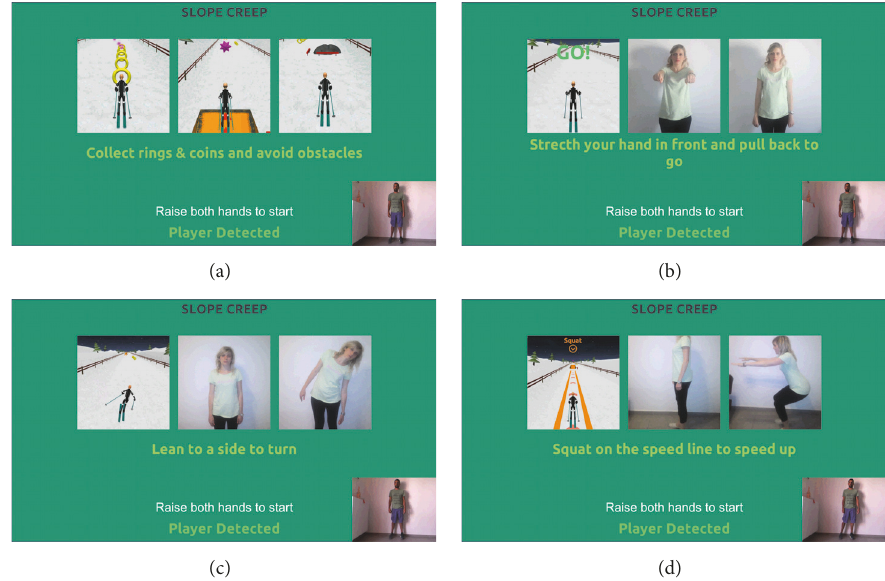
Figure10:SuccessfulrecognitionofthegestureshowninFigure 2(b)selectsandactivatestheSlopeCreepgame.Thegamestartsbydisplaying four screens (a through d in the current figure) stating the objective of the game and easy to follow directions on how to cause the on screen avatar to accelerate, turn, and